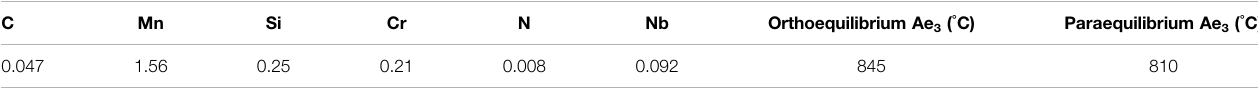
TABLE 1 | The chemical composition (mass%) and transformation temperatures of the present X70